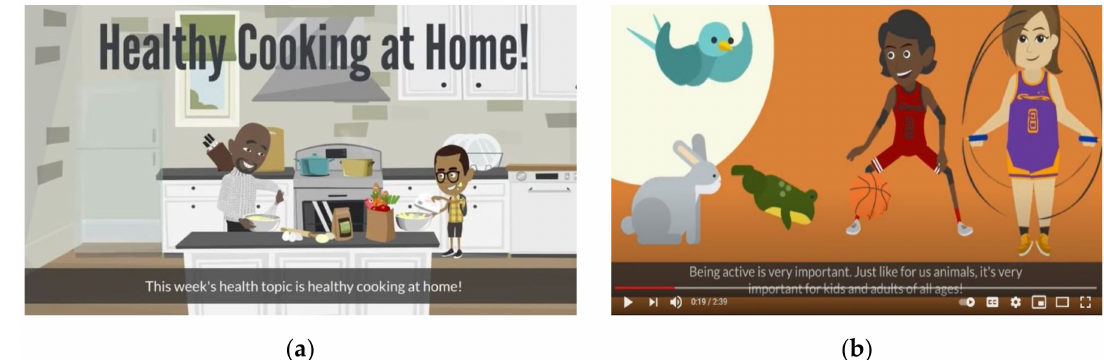
Figure 2. Screenshots of YouTube video content: ( a ) image from the Healthy Cooking at Home video; ( b ) image from the Physical activity